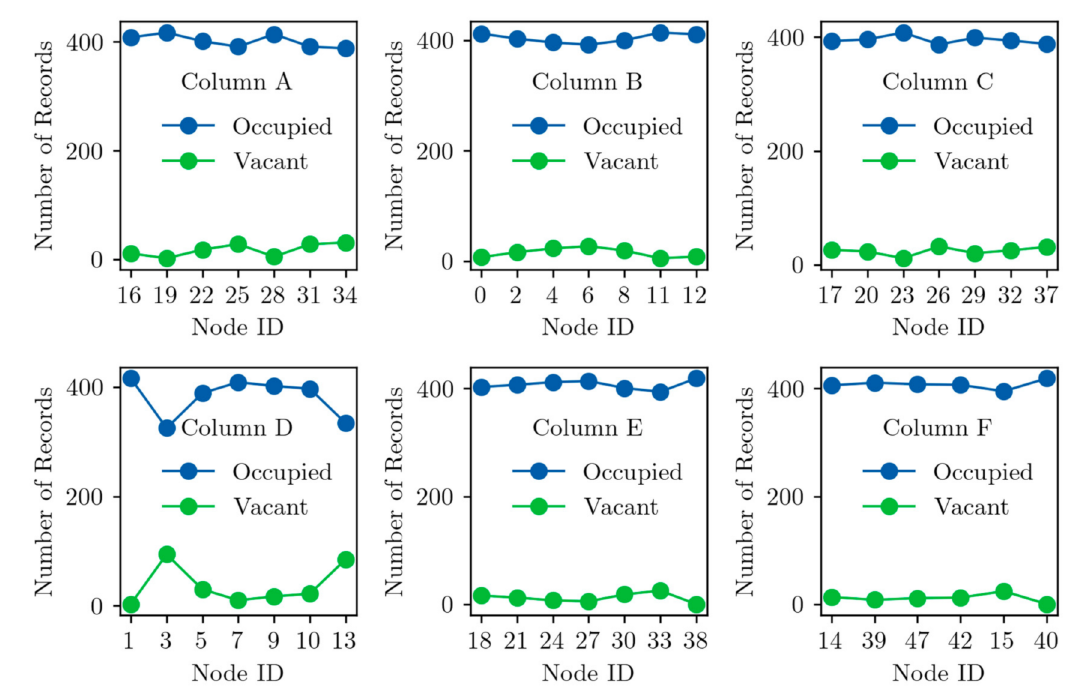
Figure 8. The individual transmission performance of data packets from slave nodes mounted on six columns in the WSN